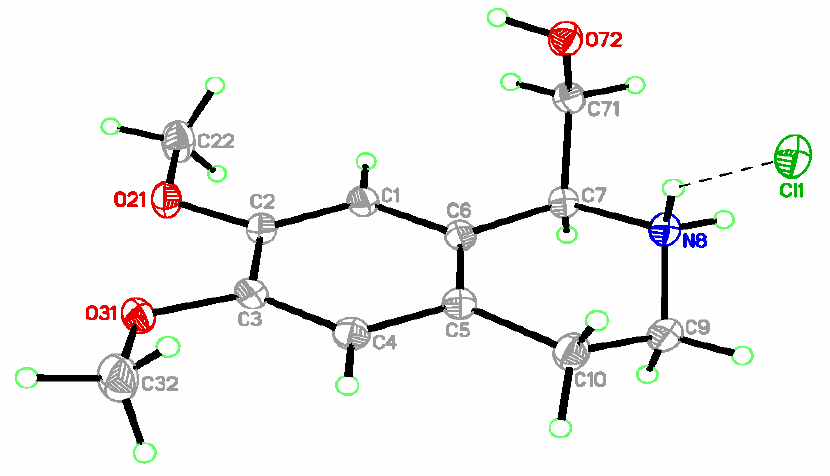
Figure 2. ORTEP view of ( 2 ) showing the atomic labelling scheme, with H atoms omitted for clarity. Thermal ellipsoids drawn at 50% probability